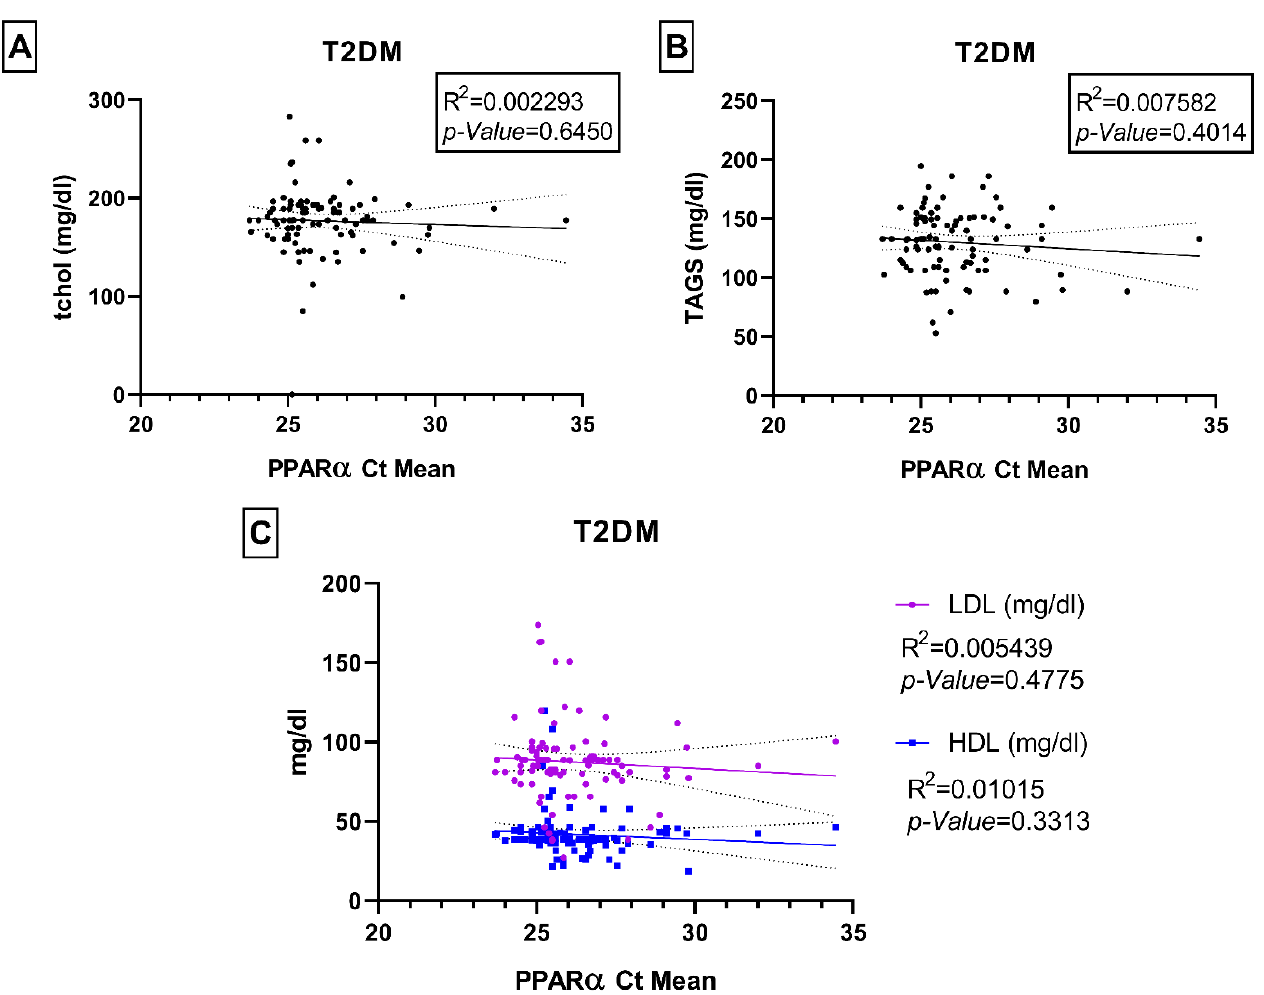
Figure 6. Relationship between PPAR α Ct mean and biomedical parameters of total serum cholesterol (tchol mg/dl) ( A ), serum triglycerides (TAGS mg/dl) ( B ), low-density lipoprotein (LDL mg/dl) and high-density lipoprotein (HDL mg/dl) ( C ) in T2DM group. Each dot of the scattered plot represents the data of individual participants.